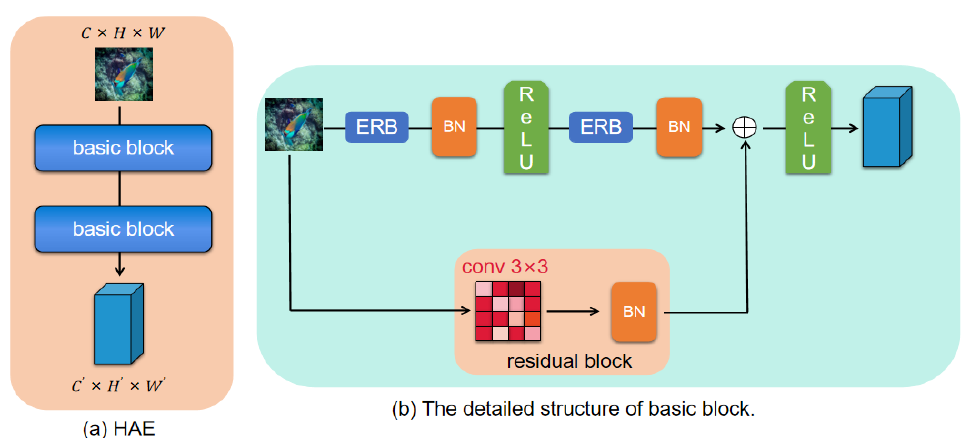
Figure 2. The overall structure of the HAE. ( a ) The connection structure of the HAE, which consists of two basic blocks in series. ( b ) The specific connection of each network layer in basic block.